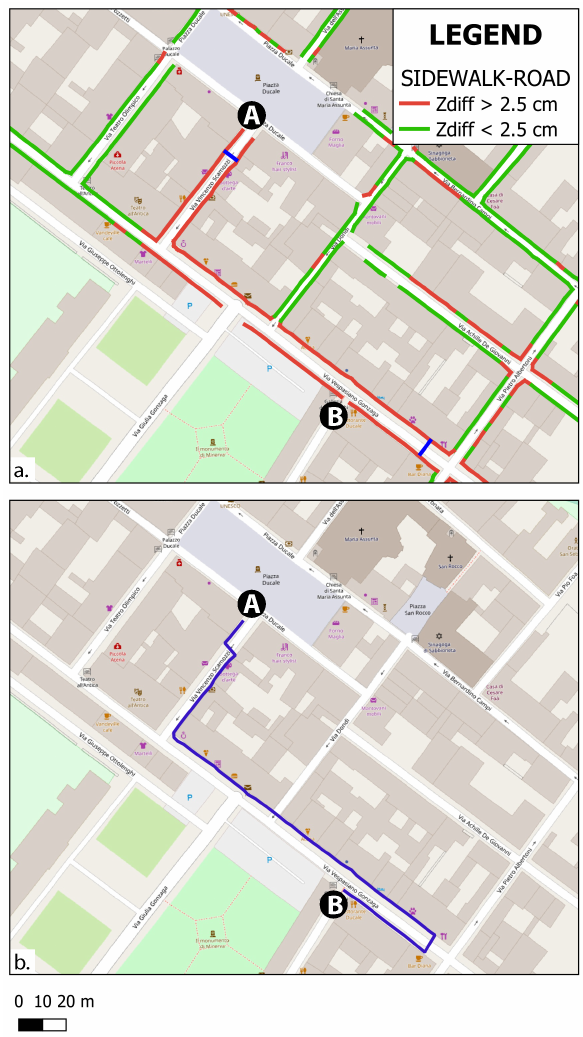
Figure 8. Test 2: computation of path considering Z difference between sidewalks and roads as a constraints. The path is com- puted from point A to point B. (a) sidewalk Z-difference thematic map; (b) shortest path considering also the presence of ramps on